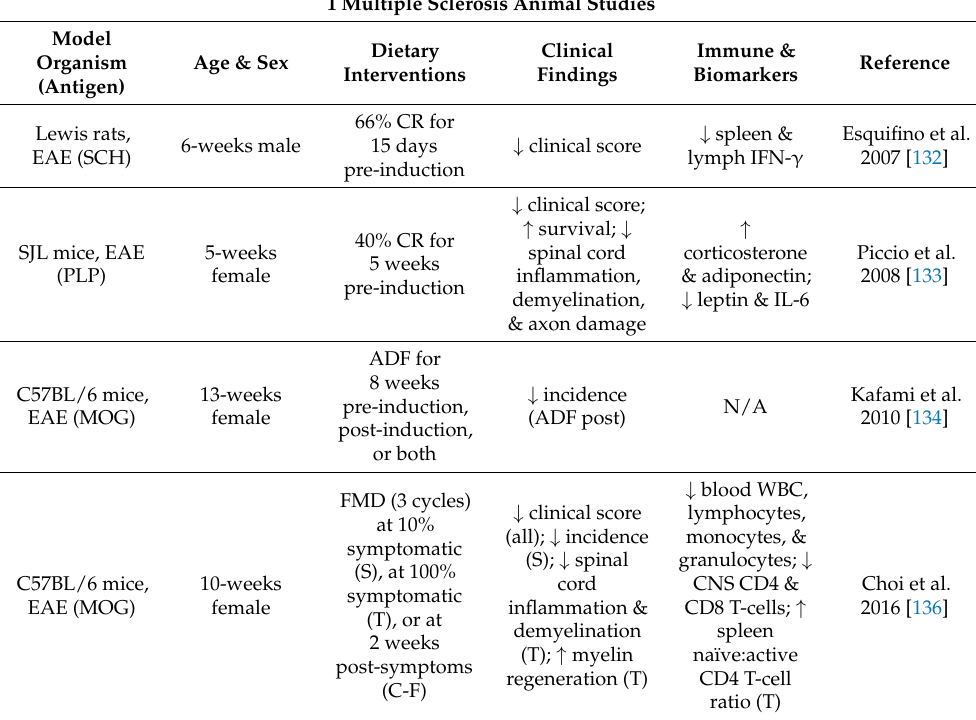
Table 4. All reviewed studies investigating the effects of DR in MS. N/A: relevant data not reported; n/s: relevant data not significant; EAE: experimental autoimmune encephalomyelitis; SCH: spinal cord homogenate; PLP: proteolipid protein; MOG: myelin oligodendrocyte glycoprotein; CNS: central nervous system; BHB: beta-hydroxybutyrate; RRMS: relapsing remitting multiple sclerosis; QOL: quality of